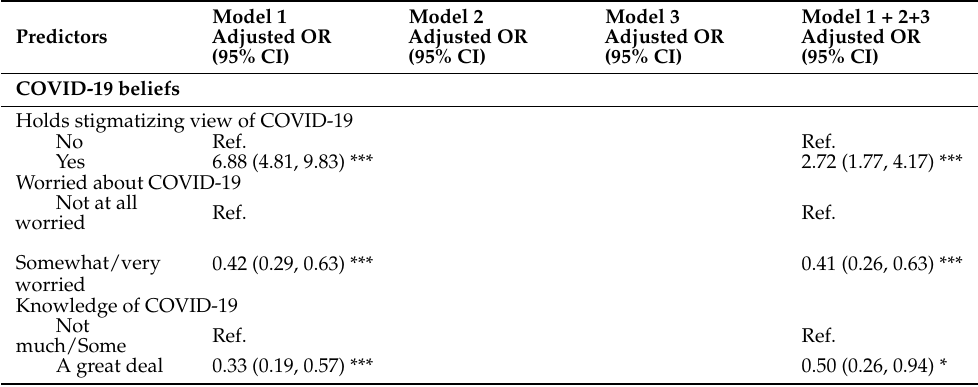
Table A2. The regression models of primary correlates predicting anti-vaccine † attitudes, Non- Representative National sample, N =